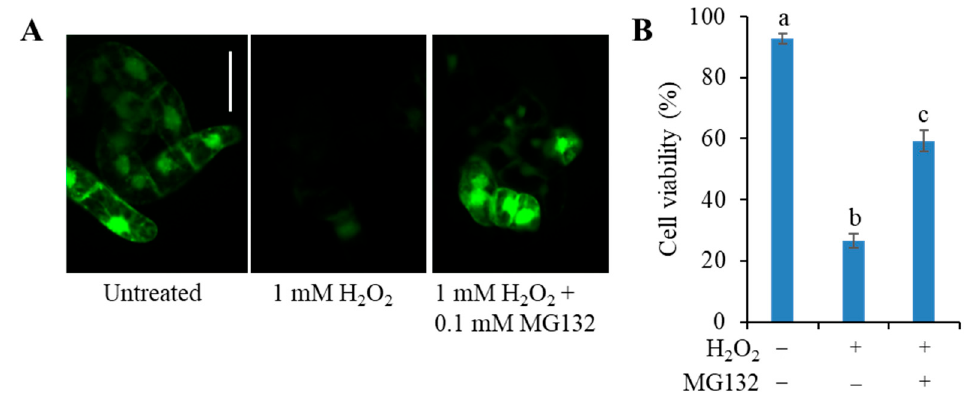
Figure 4 . Effect of MG132 on the cell survival in H 2 O 2 -treated tobacco BY-2 cells. Four-d cultured cells were treated with either 1 mM H 2 O 2 or 1 mM H 2 O 2 plus 0.1 mM MG132. MG132 was added 30 min before addition of H 2 O 2 . After 5-h incubation, cell death was determined with FDA staining, as in Figure 1. ( A ) Typical photographs are shown: untreated cells as control (left), treated with H 2 O 2 at 1 mM (middle), and H 2 O 2 at 0.2 mM plus 0.1 mM MG132 (right). Bar = 50 µm. ( B ) Cell viability (%). All values are mean ± SE, and the data represent three independent experiments. Different letters represent significantly different values ( p < 0.05 on Tukey test).